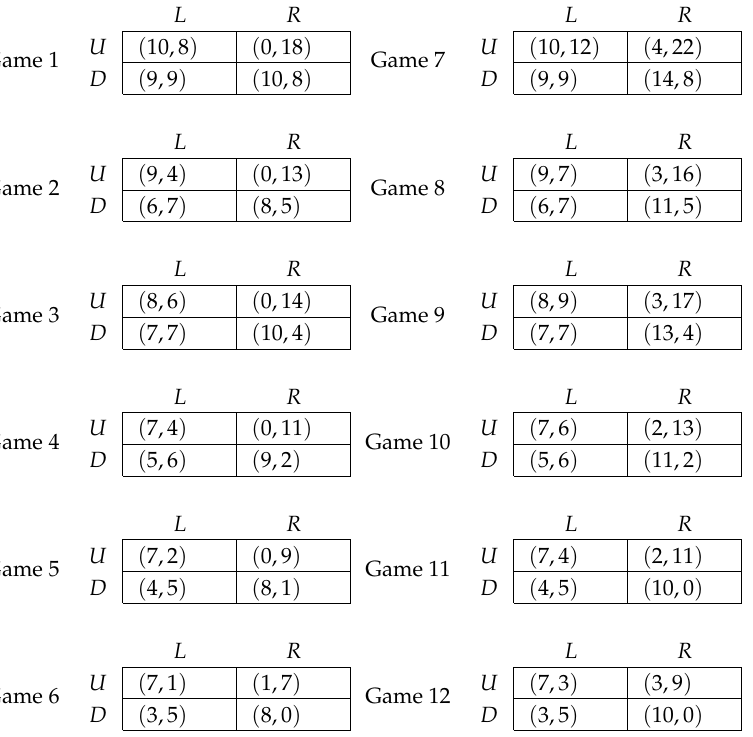
Figure 1. 2x2 Games. Figure 1. 2